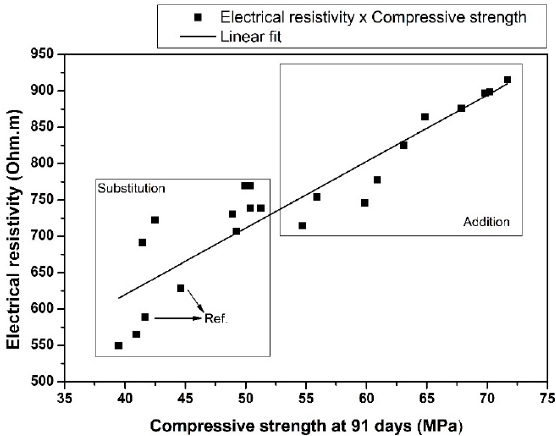
Figure 10. Relation between electrical resistivity and compressive strength.